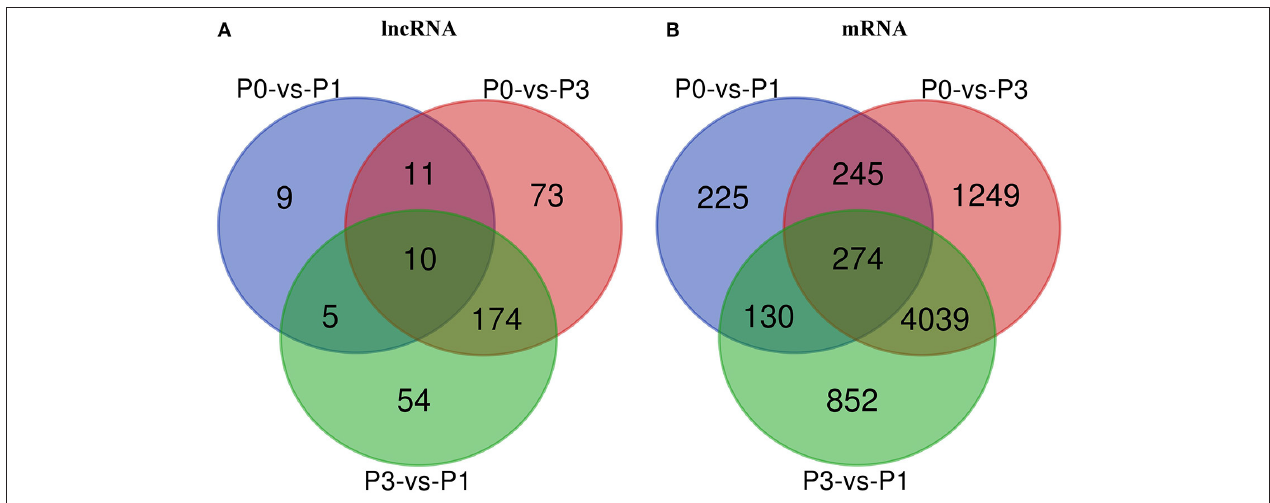
FIGURE 1 | Venn diagram showing the common DE lncRNAs (A) and mRNAs (B) in the three comparison groups: P0-vs.-P1, P0-vs.-P3, and P3-vs.-P1.